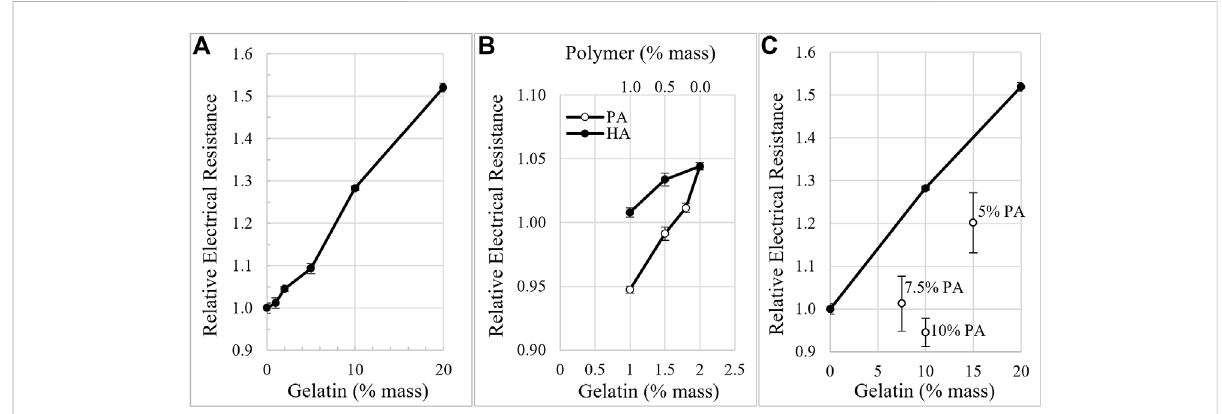
FIGURE 2 Matrixdensityandcompositionin fl uenceelectricalresistance. (A). Electricalresistanceofgelatin- fi lledIBIDIchannelsinRinger ’ s,increaseswith gelatin concentration. (B) . Electrical resistance of the matrices in Ringer ’ s decreases with increasing amounts of anionic polymers compared to a similarpercentweightofgelatinalone.2%wasthetotalcombinedweightpercentofthemixturesofHAandPAwithgelatin. (C) .Electricalresistance (cid:129) of high concentrations of gelatin alone ( ) decreases when higher concentrations of PA are